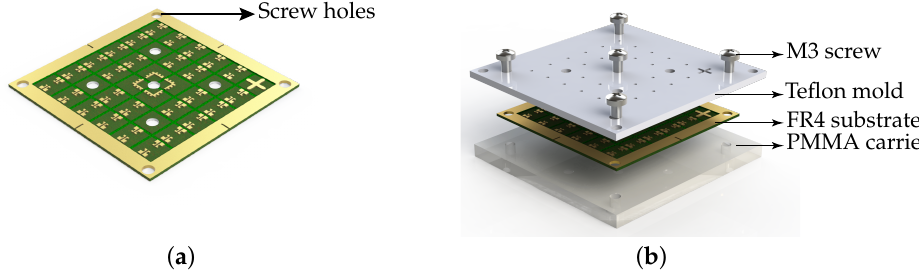
Figure 4. Schematic of the substrate during each fabrication process steps. ( a ) Substrate with contact pads after CNC milling; ( b ) An exploded view of the clamping assembly.